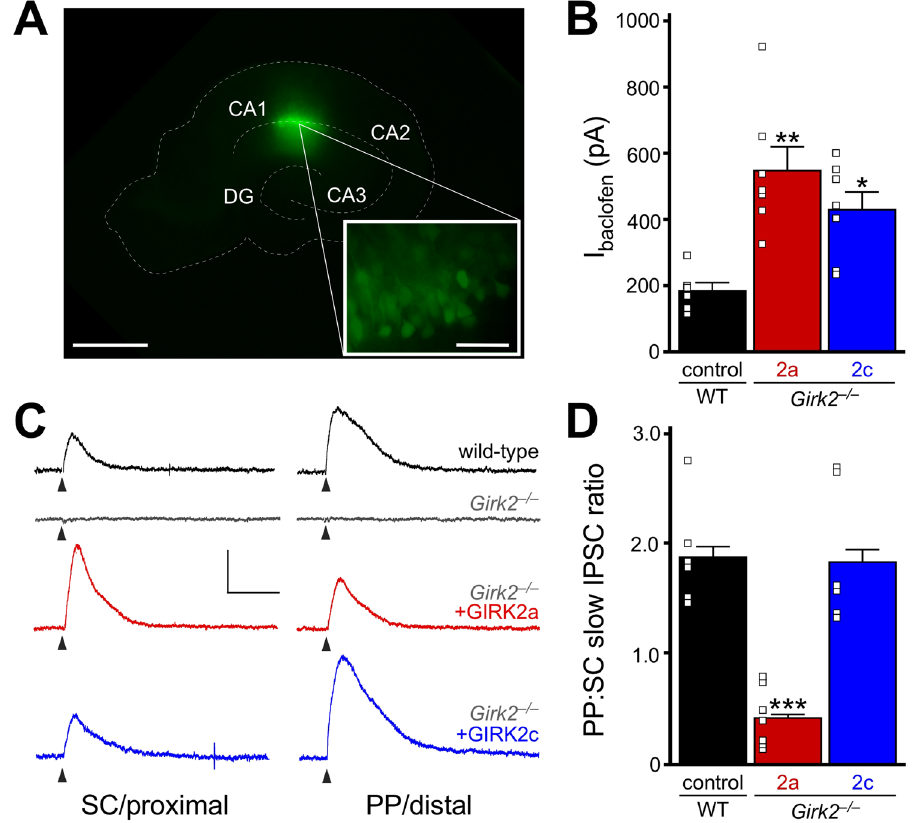
Figure 6. Synaptic GIRK currents in Girk2 − / − neurons expressing GIRK2a and GIRK2c. ( A ) Image showing EGFP expression in the CA1 region of an organotypic hippocampal slice, taken 7 d after infection with AAV8- hSyn-GIRK2a-IRES-EGFP. The dotted white line highlights key features of slice morphology. Scale bar: 500 microns (inset: 50 microns). ( B ) Summary of peak baclofen-induced somatodendritic current amplitudes (I baclofen ) in dorsal CA1 pyramidal neurons, measured 7 d after CA1 infusion of control virus (con) to wild- type (WT) organotypic slices, or GIRK2 expression viruses (2a, 2c) to Girk2 − / − organotypic slices (F 2,17 = 1.2, P < 0.01; n = 6–7/group). Symbols * , ** P < 0.05 and 0.01, respectively, vs. WT. ( C ) Slow IPSCs evoked via stimulation of proximal (Schaffer collateral/SC) or distal (perforant path, PP) dendritic fields, in wild-type and Girk2 − / − CA1 pyramidal neurons expressing EGFP, as well as Girk2 − / − CA1 pyramidal neurons expressing GIRK2a or GIRK2c. The stimulus artifact and residual GABA A R-dependent responses were removed for clarity, and the triangles below the traces denote stimulation times. Scale: 100 pA/1 s. ( D ) Summary plot comparing the ratios of slow IPSC maximal amplitudes evoked by SC and PP stimulation in wild-type CA1 pyramidal neurons expressing EGFP, as well as Girk2 − / − CA1 pyramidal neurons expressing GIRK2a or GIRK2c (F 2,37 = 51.9; P < 0.001; n = 6–8/group). Maximal responses evoked by stimulation of SC and PP fields were measured in each neuron, in counterbalanced fashion. Symbols: *** P < 0.001 vs. WT (control) and Girk2 − / −